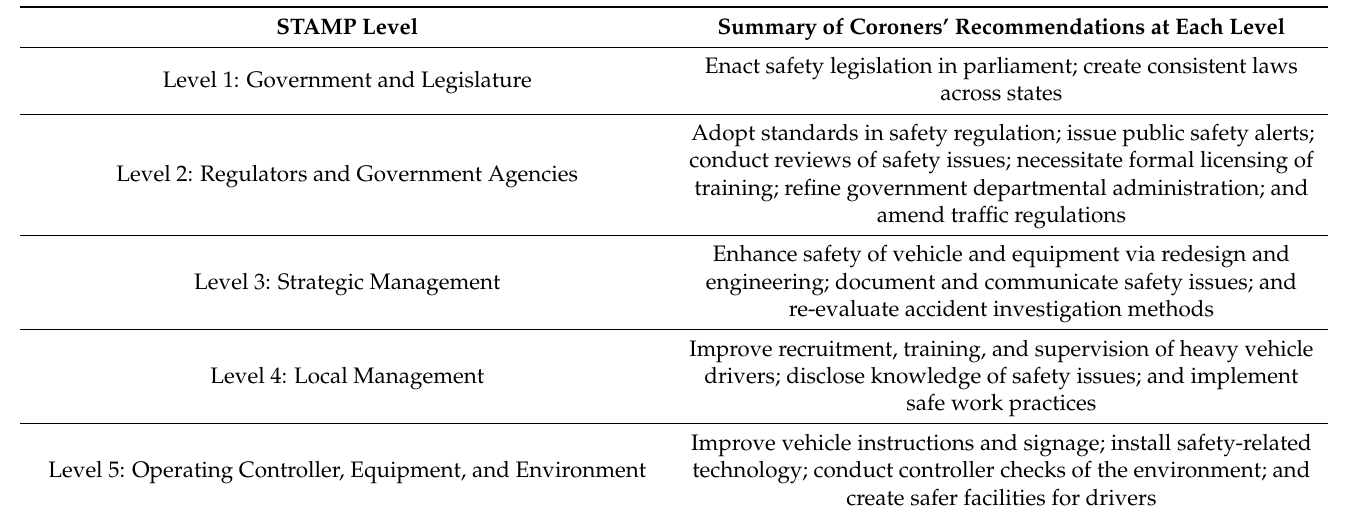
Table 5. Summary of Recommendations by Coroners at each STAMP